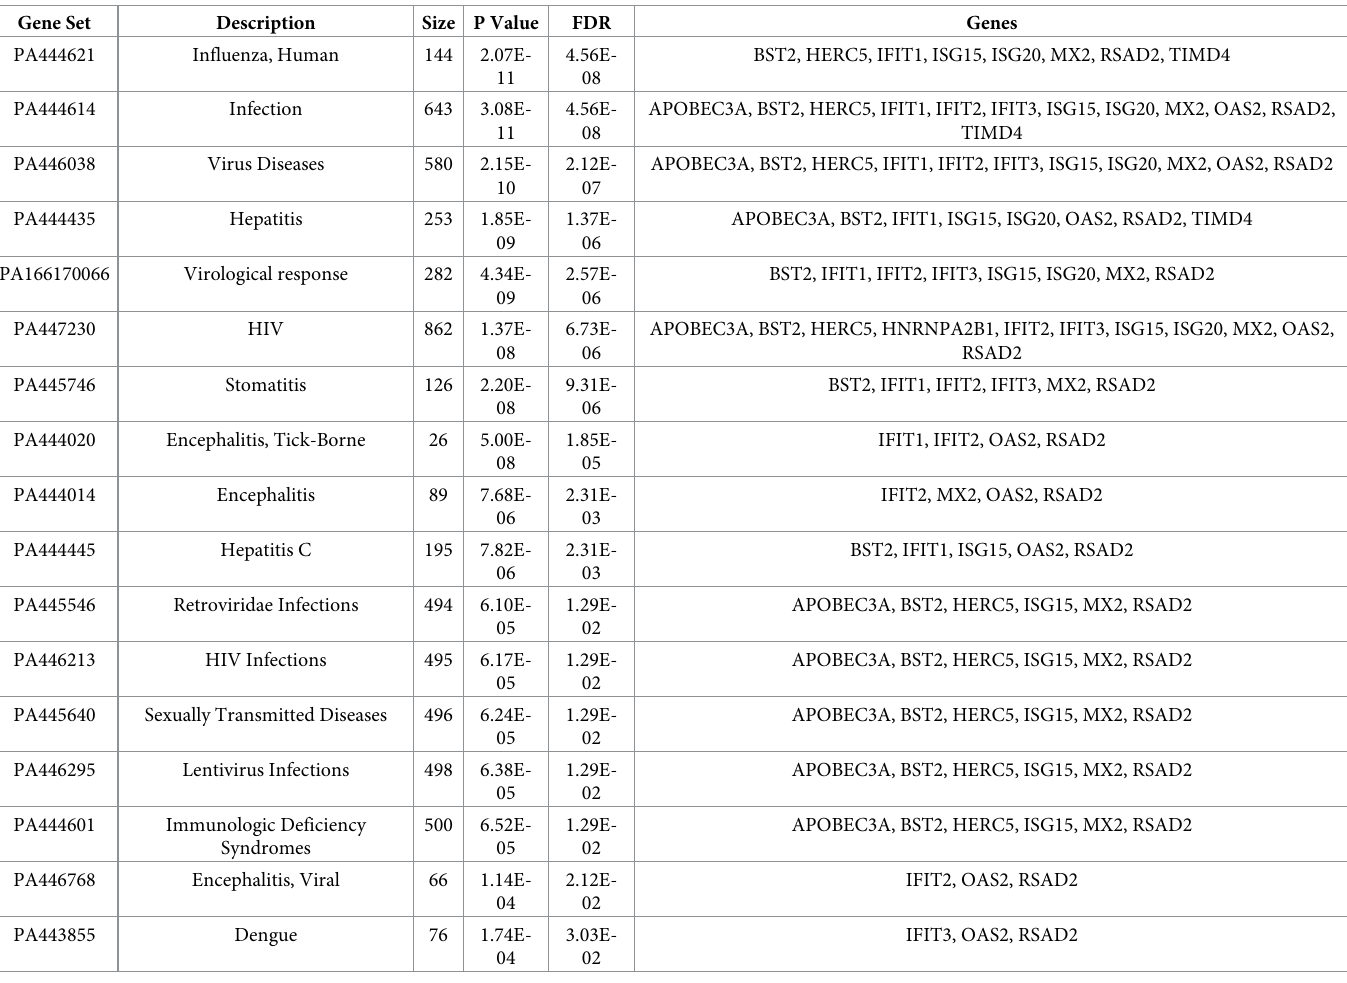
Table 3. Top enriched disease phenotypes (FDR < 0.05).